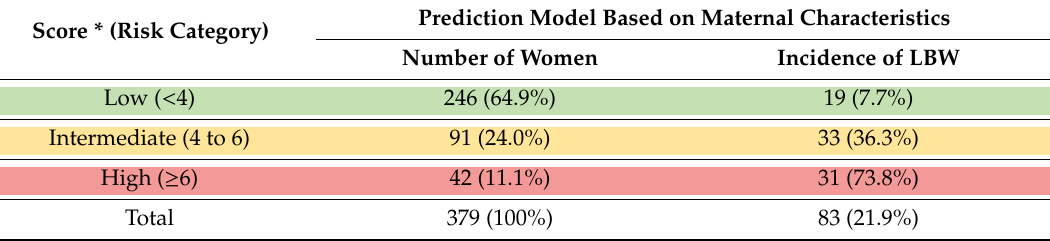
Table 3. Risk classification of low birthweight using simplified prediction score ( n = 379). Prediction Model Based on Maternal Characteristics Score * (Risk Category) Number of Women Incidence of LBW Low ( < 4) 246 (64.9%) 19 (7.7%) Intermediate (4 to 6) 91 (24.0%) 33 (36.3%) High ( ≥ 6) 42 (11.1%) 31 (73.8%) Total 379 (100%) 83 (21.9%) * Score = (age < 20 *2.5) + (BMI < 18.5*2.5) + (hemoglobin < 11 mg / dl*2) + (height < 155 cm*2) + (prim-gravid*1) + (presence of chronic